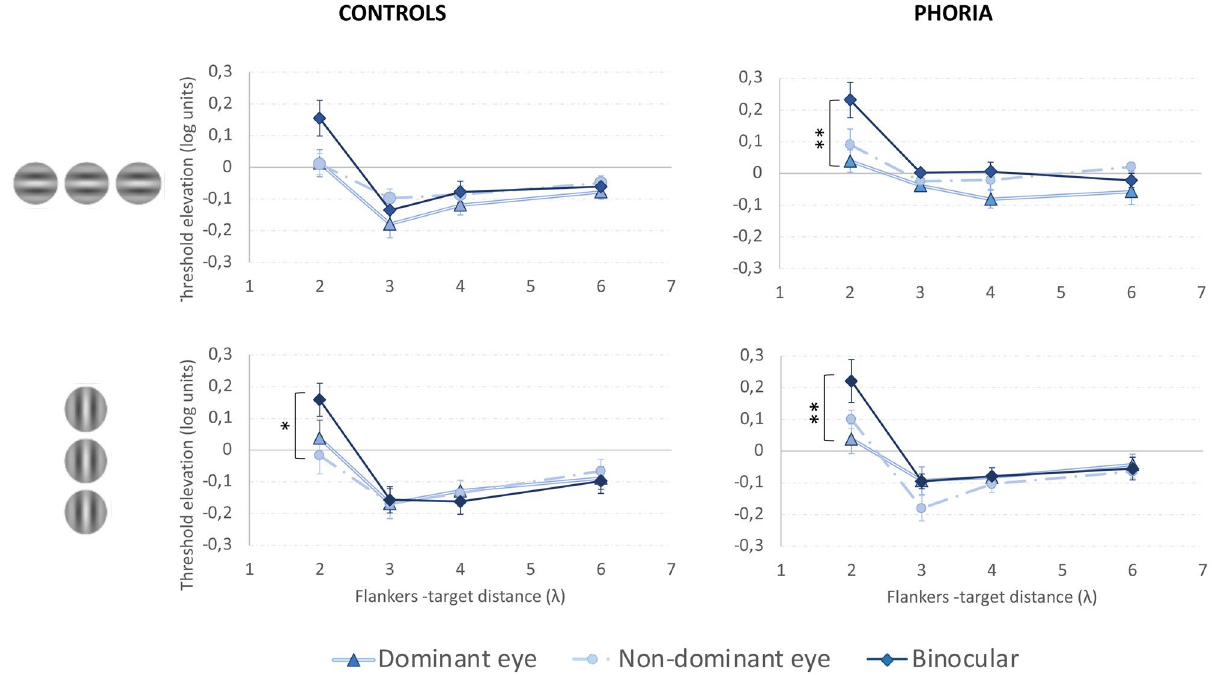
Figure 6. Threshold elevation (in log units) as a function of the flanker-target distance (in λ) for the control group (left) and the heterophoric group (right) at a viewing distance of one meter for a target orientation of 0° (the upper line of graphs) and 90° (the lower line of graphs). Facilitation is indicated by values below zero, and suppression by values above zero. The light blue line and the filled circles denote the results of the non-dominant eye, the double blue line and the filled triangle denote the results of the dominant eye, and the dark blue line with the filled diamonds denotes the results for binocular viewing. The error bars denote the standard error of the mean. *** p ≤ 0.001, ** p ≤ 0.01, * p ≤